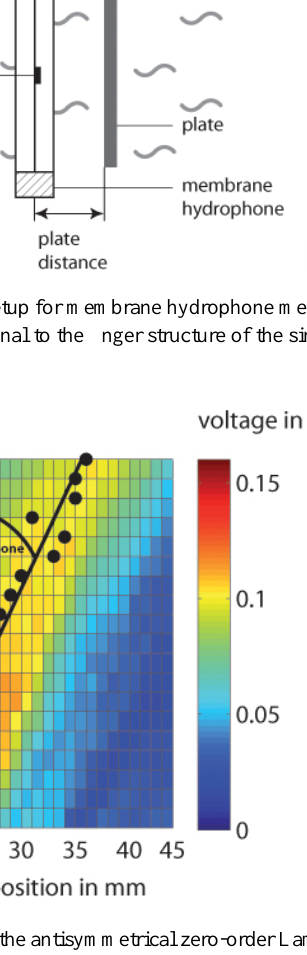
Figure 9. Emission profile of the antisymmetrical zero-order Lamb wave mode on a glass plate of 1mm thickness.